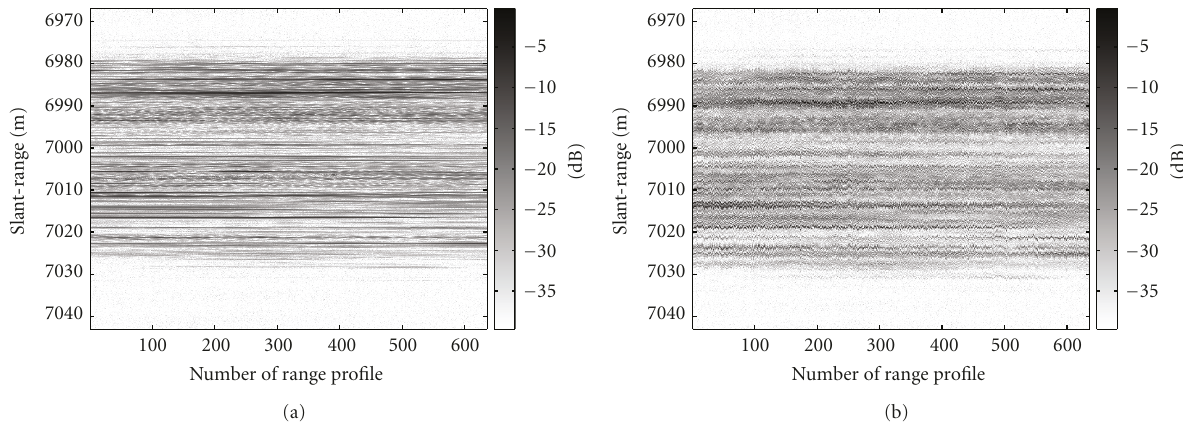
Figure 18: Range profiles aligned after applying (a) the proposed subinteger range-bin alignment method and (b) the global range alignment algorithm to the vessel data with artificially induced vibration.